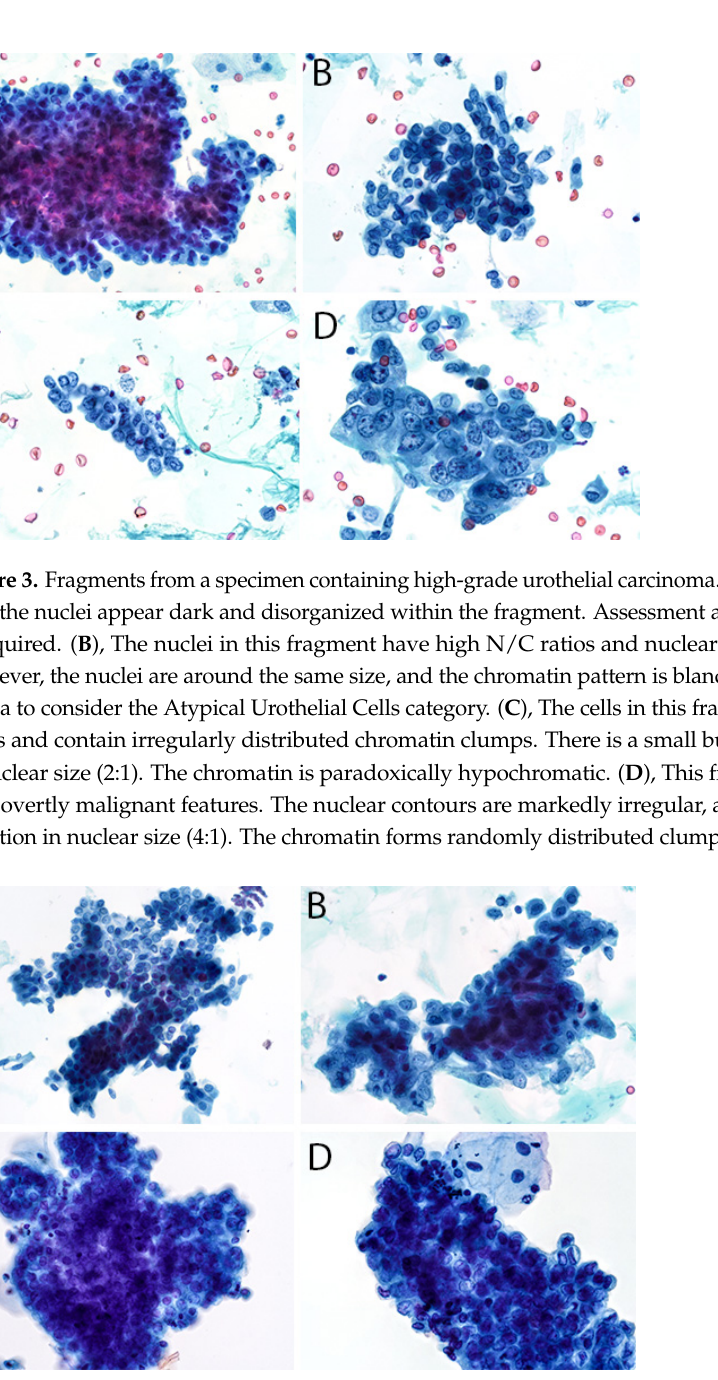
ciated. The cells at the edges of the fragment do not have elevated N/C ratios, with their cytoplasm forming a “collarette”.